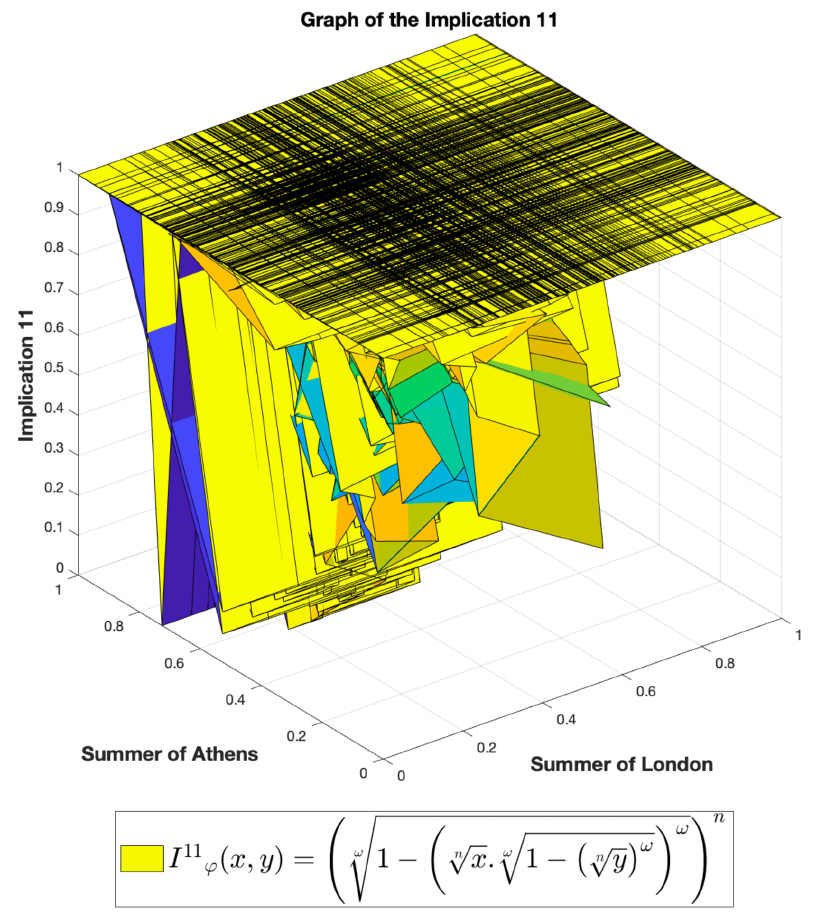
Figure 14. Graph of the Implication